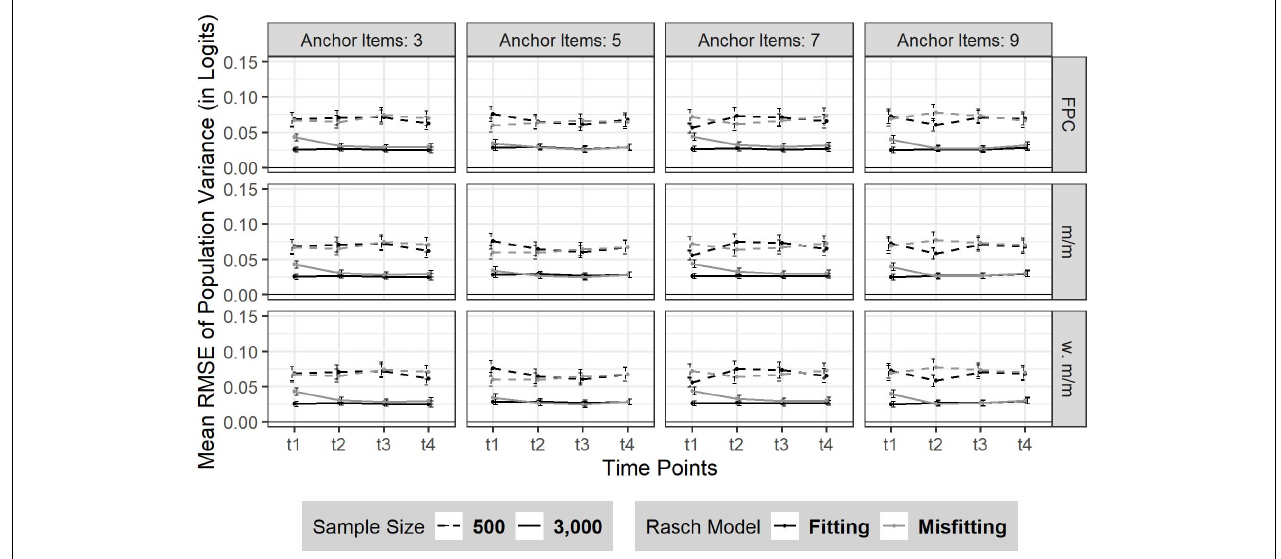
FIGURE 4 | RMSE of sample variance over four time points (t 1 –t 4 ). The figure is split by three linking methods and the experimental factors number of anchor items, sample size and Rasch model-data fit. FPC = fixed parameter calibration, Mean/Mean = mean/mean linking, w. Mean/Mean = weighted Mean/Mean. 95% confidence intervals are